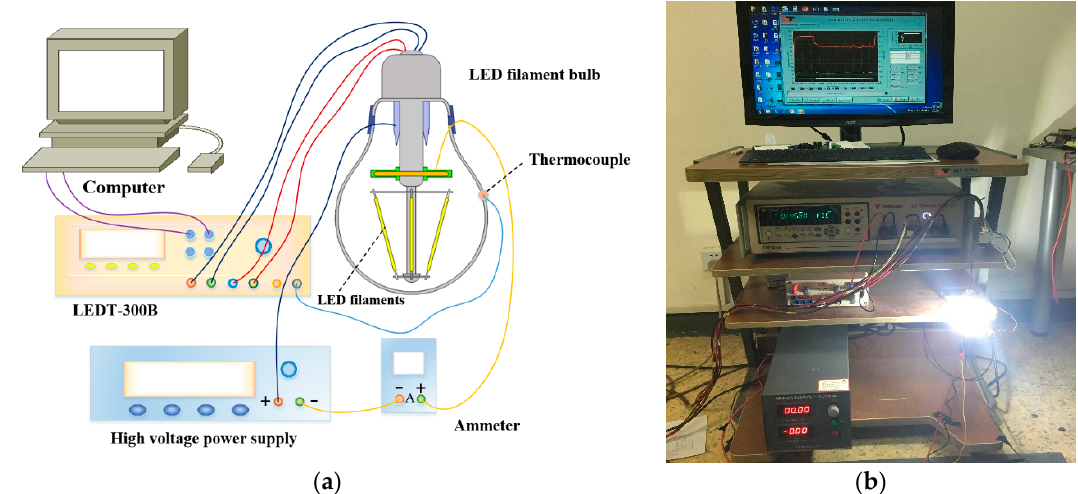
Figure 2. Experimental setup for measuring junction temperature of LED filament bulb: ( a ) system frame chart for measuring junction temperature of LED filament bulb; and, ( b ) photograph of experiment on measuring junction temperature of LED filament bulb.